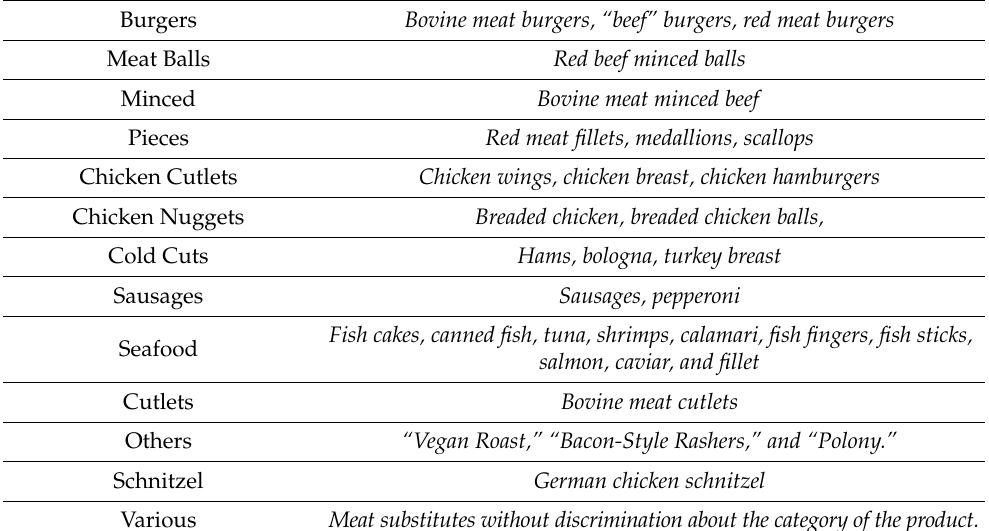
Table 1. Developed categories and their respective components. Burgers Bovine meat burgers, “beef” burgers, red meat burgers Meat Balls Red beef minced